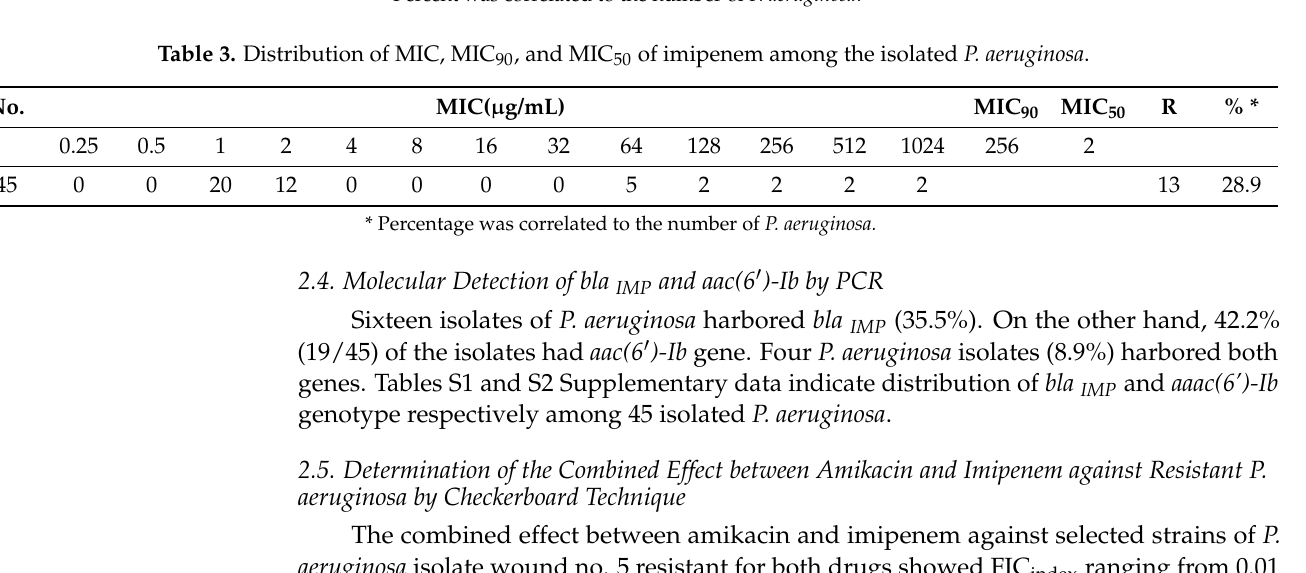
Table 4. The combined effect between imipenem and amikacin against selected resistant P. aeruginosa isolates. P. aeruginosa Wound isolate no. 5 Ear isolate no. 3 Burn isolate no. 3 Chest infection isolate no.